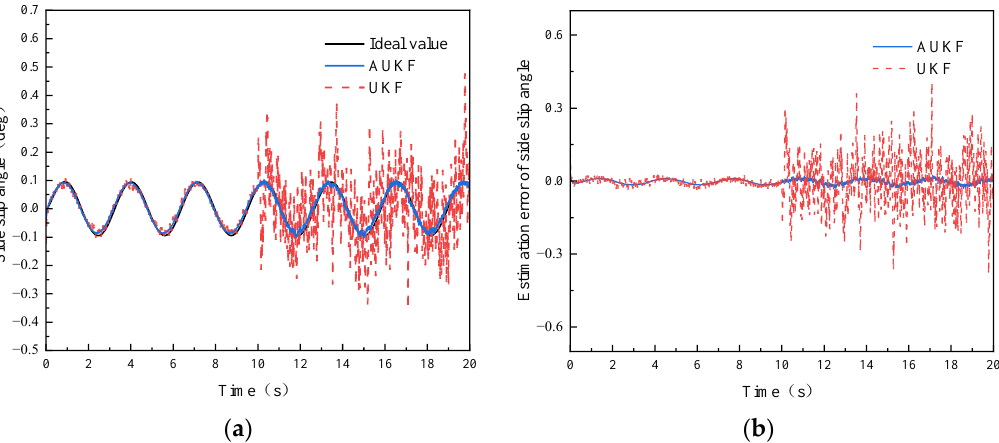
Figure 10. Simulation results of side slip angle. ( a ) Comparison of estimated results and ( b ) comparison of estimated error.